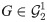
An example graph G∈G21 where |V| = 23, |E| = 35.